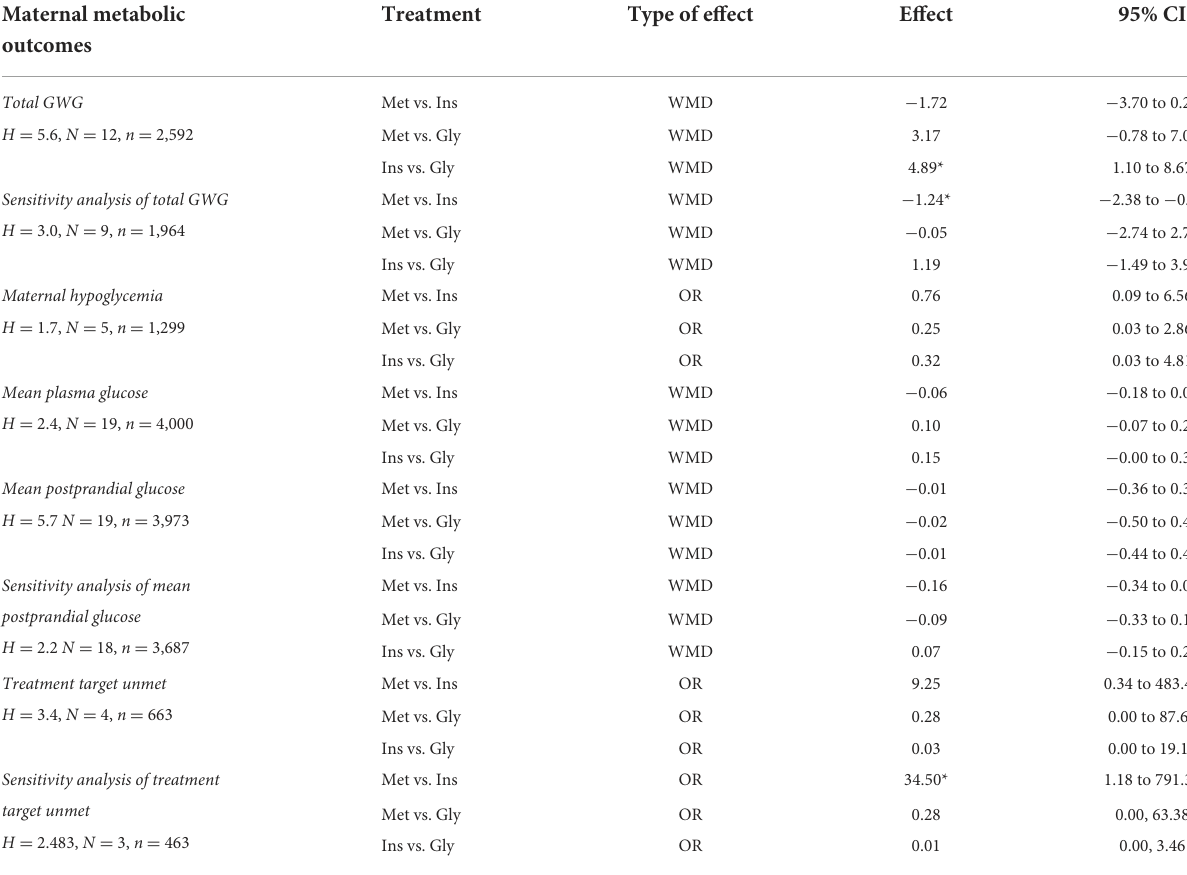
TABLE 2 The Bayesian network-analysis for maternal metabolic outcomes. Maternal metabolic